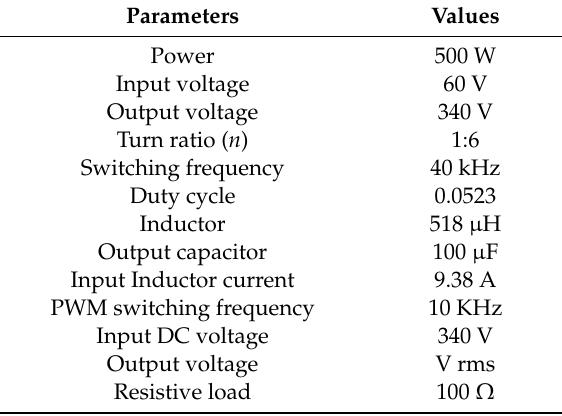
Table 2. Design parameters of the push pull converter. PWM, pulse width